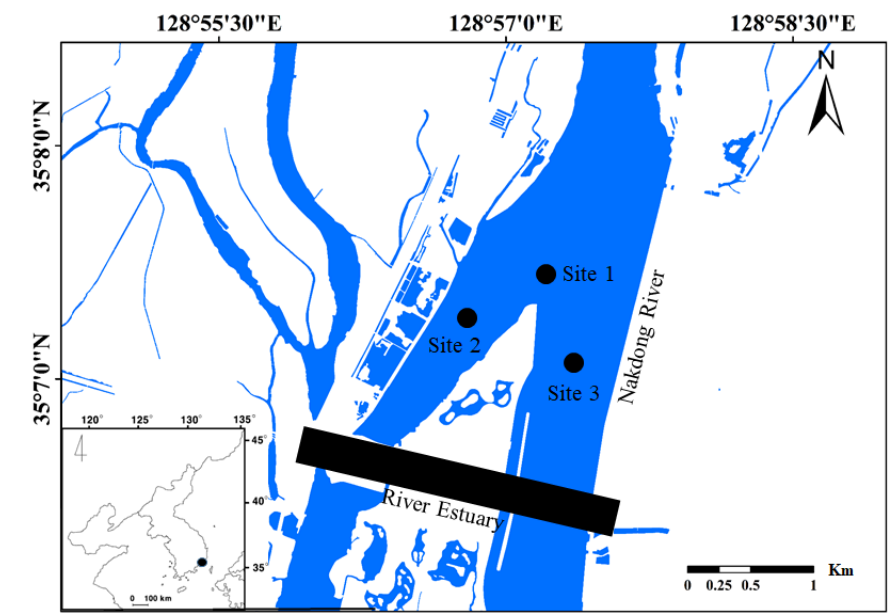
Figure 1. Map of the study area in the Nakdong River estuary. The study sites are indicated as solid circles ( • ). The inset map in the lower-left corner indicates the estuary’s location in the Korean Peninsula.